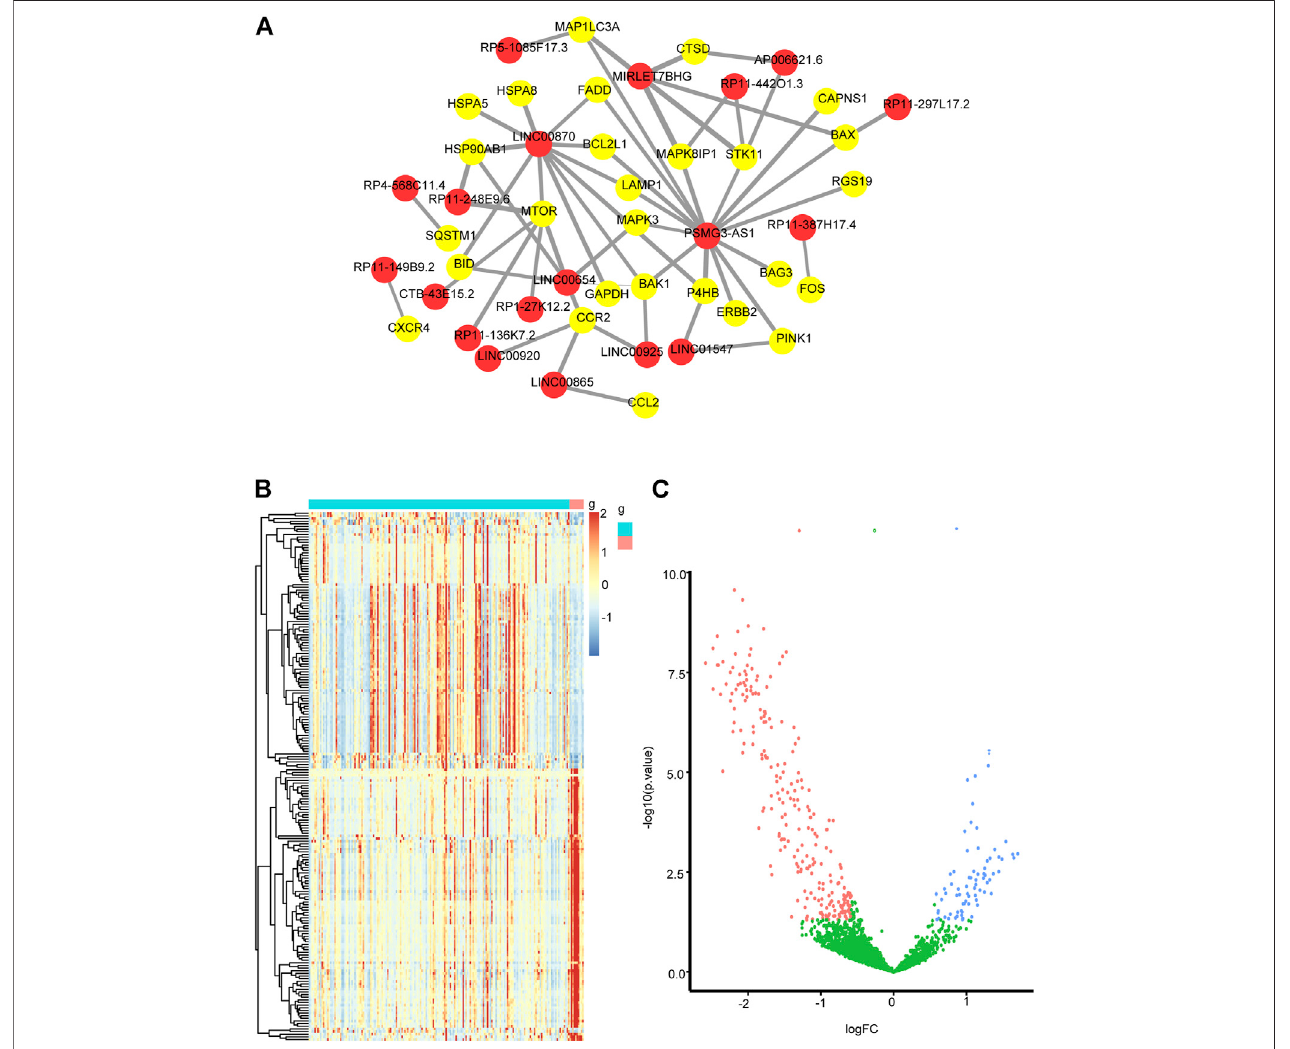
FIGURE 4 | (A) Regulatory networks between autophagy-related lncRNAs and autophagy-related genes. The red dots mark lncRNAs, the yellow dots mark autophagy-related genes (|r| > 0.4, p < 0.05). (B) a heatmap of DEmiRNAs in GSE185062 (|log2 fold change| > 0.58; p < 0.05) and (C) a volcano plot of DEmiRNAs in GSE185062 (|log2 fold change| > 0.58; p <